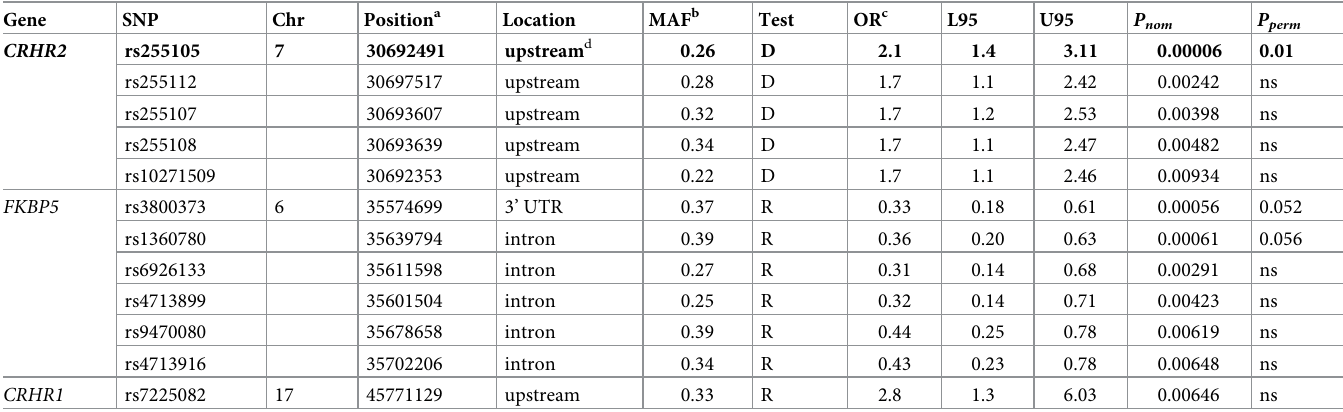
Table 2. Top associations in the discovery EA sample ( P nom < 0.01).